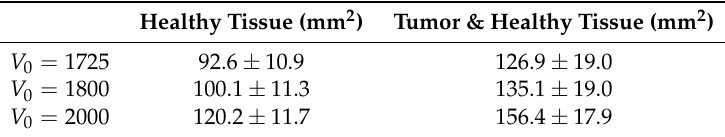
Table 10. Ablation sizes for IRE threshold at >700